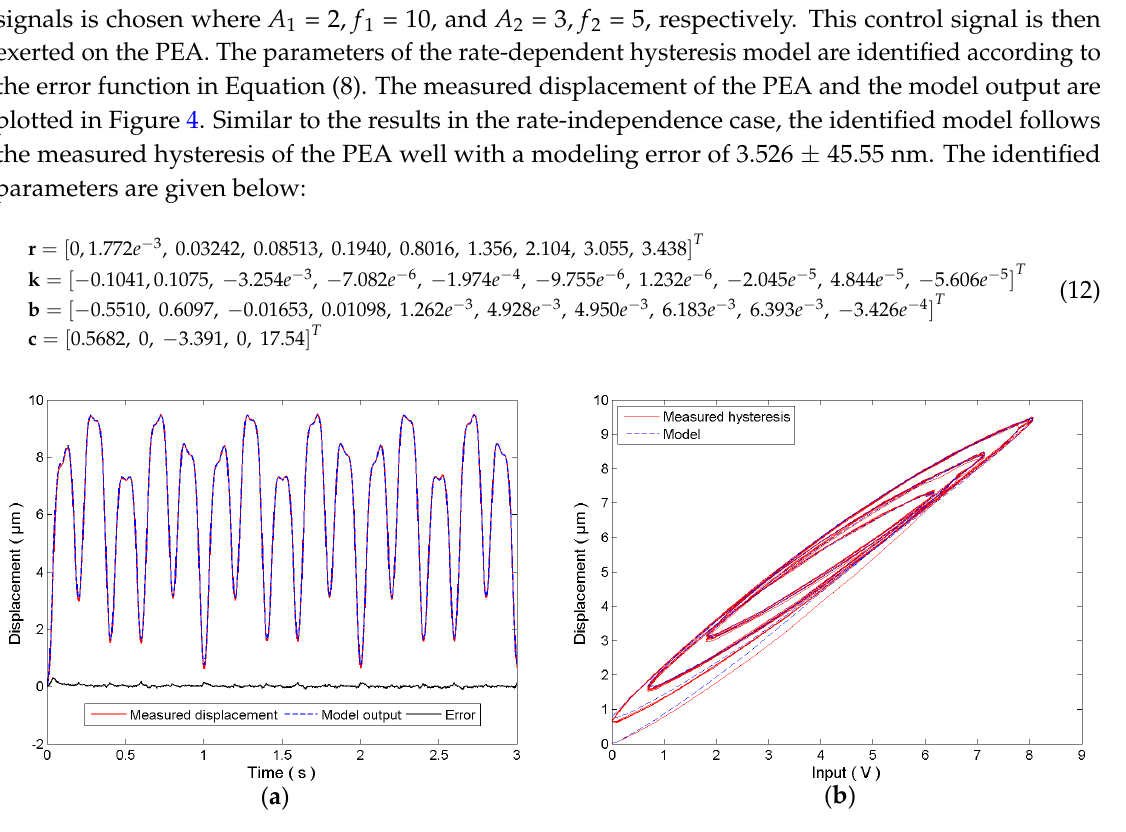
Figure 4. Identification of the rate-dependent hysteresis model using the superimposition of two sinusoidal signals: ( a ) time plot and ( b ) hysteresis plot.